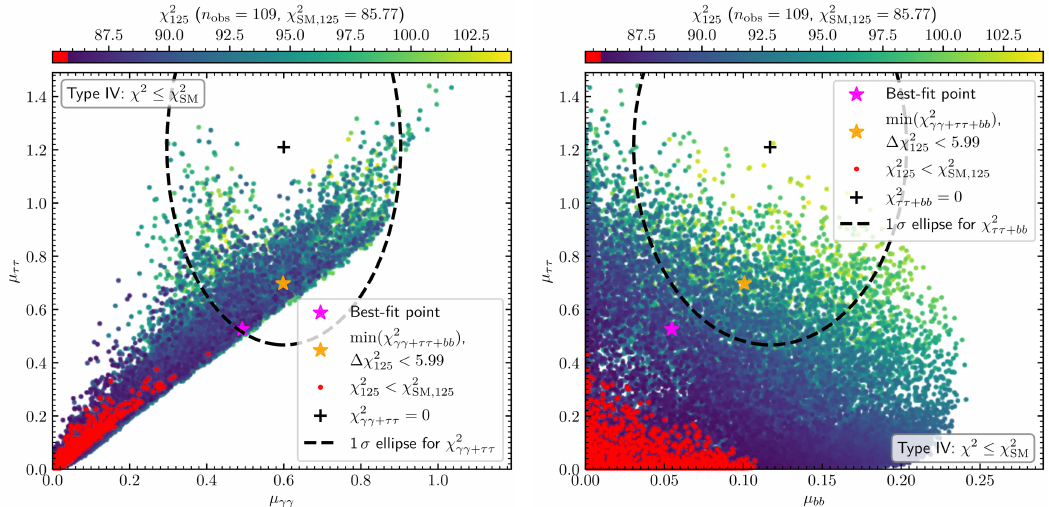
Figure 3 . µ ττ in dependence of µ γγ (left) and µ bb (right). The 1 σ confidence-level regions with regard to χ 2 + χ 2 (left) and χ 2 + χ 2 (right) are indicated by the dashed black line. The color γγ ττ ττ bb coding is as in figure